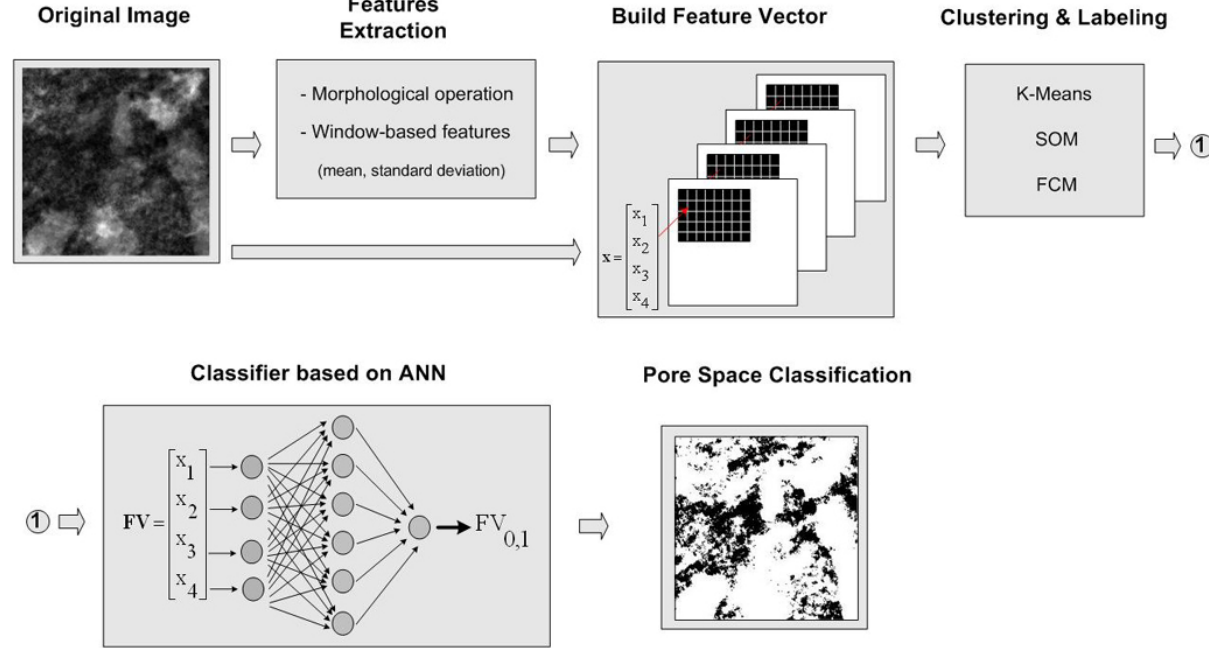
Fig. 1. The block diagram of our proposed